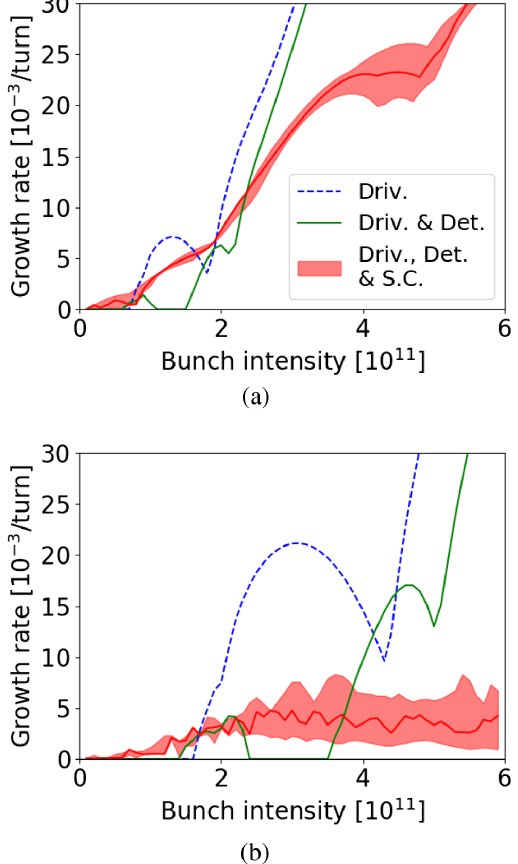
FIG. 10. Maximum growth rate obtained for a Gaussian distribution in configurations corresponding to an experiment conducted at the SPS with two different optics labeled Q26 (above) and Q20 (below) [8]. The result of the CMM without space charge forces but with either only the detuning wakefields or both the detuning and driving wakefields are shown with blue and green curves respectively. They were obtained with 80 slices and 40 rings. The red lines and shaded areas represent the configuration featuring both driving and detuning wakefields as well as space charge forces, with a range given by the uncertainty on the transverse and longitudinal emittances. They were ob- tained with 140 slices and 60 rings. (a) Q26 (b)